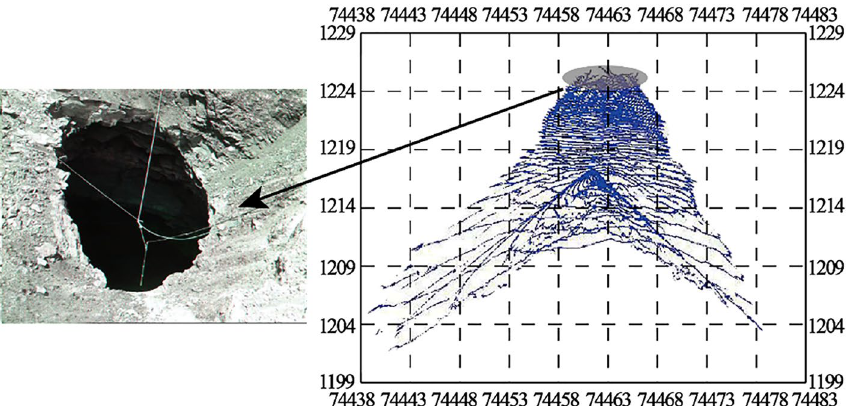
Figure 13. East open-pit mine 1225 flat 0528 cavity. It is also a typical inverted funnel-shaped cavity and this cavity has collapsed to the